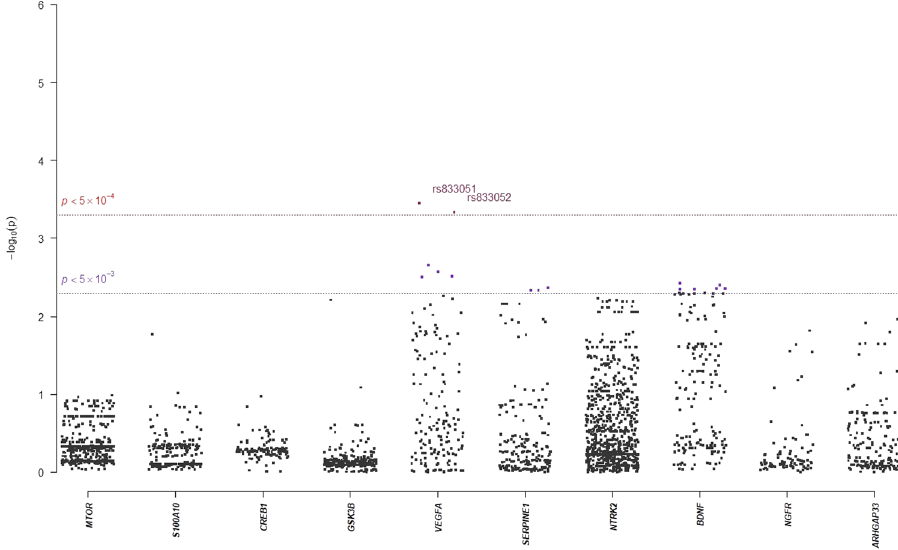
Figure 3. Manhattan plot of meta-analysis of selected candidate genes for Response (% Δ HRSD, continuous).